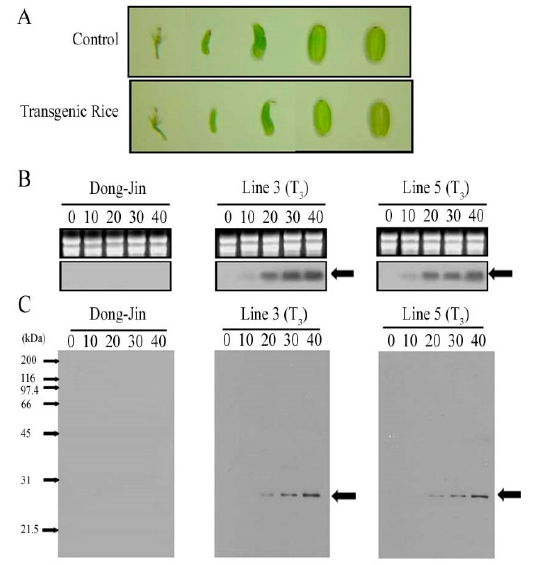
Figure 2. AvMaSp expression profiles during the development of the transgenic seeds. ( A ) Development of the transgenic seeds. The seeds were imaged every 10 days between the flowering stage and seed maturation. ( B ) Transcriptional expression profiles of AvMaSp in the transgenic lines, revealed using an RNA blot. Total RNA was extracted from the seeds harvested in ( A ). AvMaSp transcripts are indicated with an arrow. The ethidium bromide-stained RNA gel shows uniform loading (upper panel). ( C ) Translational expression profiles of the AvMaSp protein in the transgenic lines, revealed using a western blot. The proteins were extracted from the seeds harvested in ( A ). The AvMaSp proteins are indicated with an arrow.